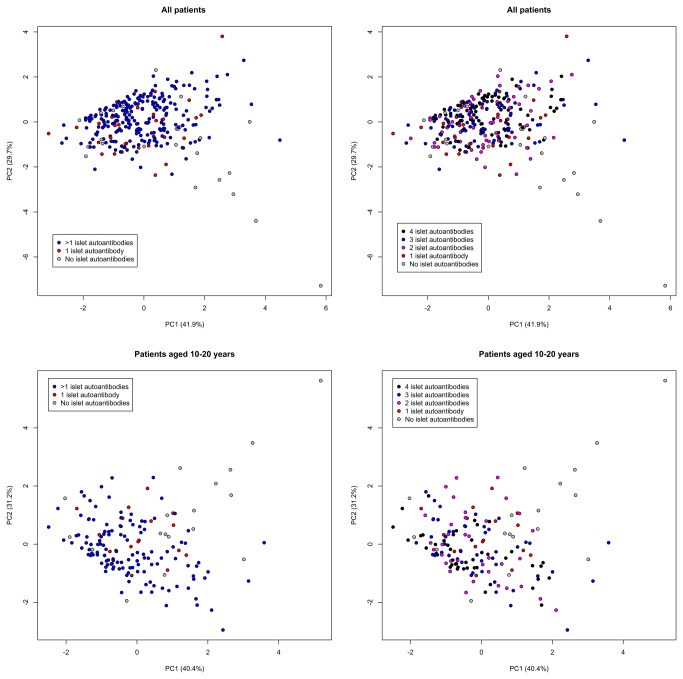
Biplots of the first two principal components (PC) determined by principal component analyses using BMI percentile, weight loss before diagnosis, fasting C-peptide, and insulin sensitivity score, according to the number of autoantibodies in the whole dataset (top) and in children aged 10–20 years (bottom).The variance explained by PC1 and PC2 is shown in parentheses along each axis.